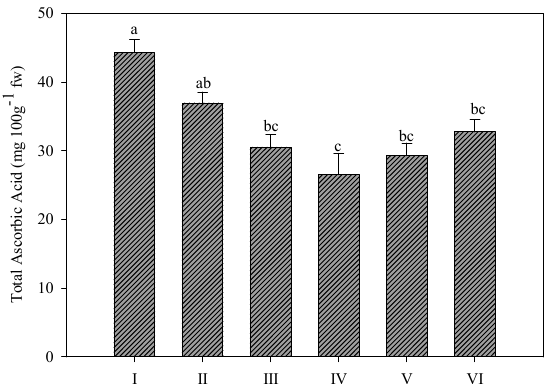
Figure 2. Effect of harvest on total ascorbic acid (TAA) (average of the experimental treatments). Different letters within each column indicate significant differences at p = 0.05 according to Tukey’s multiple range test.